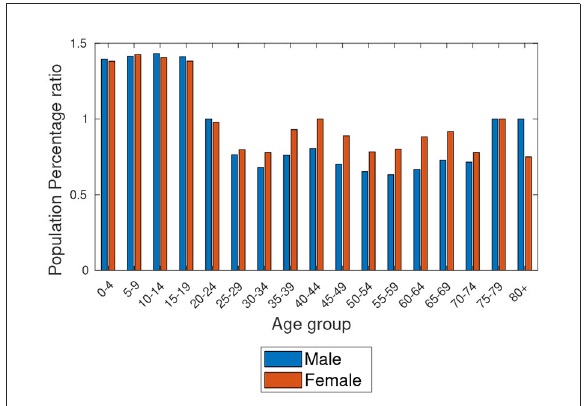
FIGURE1 Age structures of the populations of Botswana.